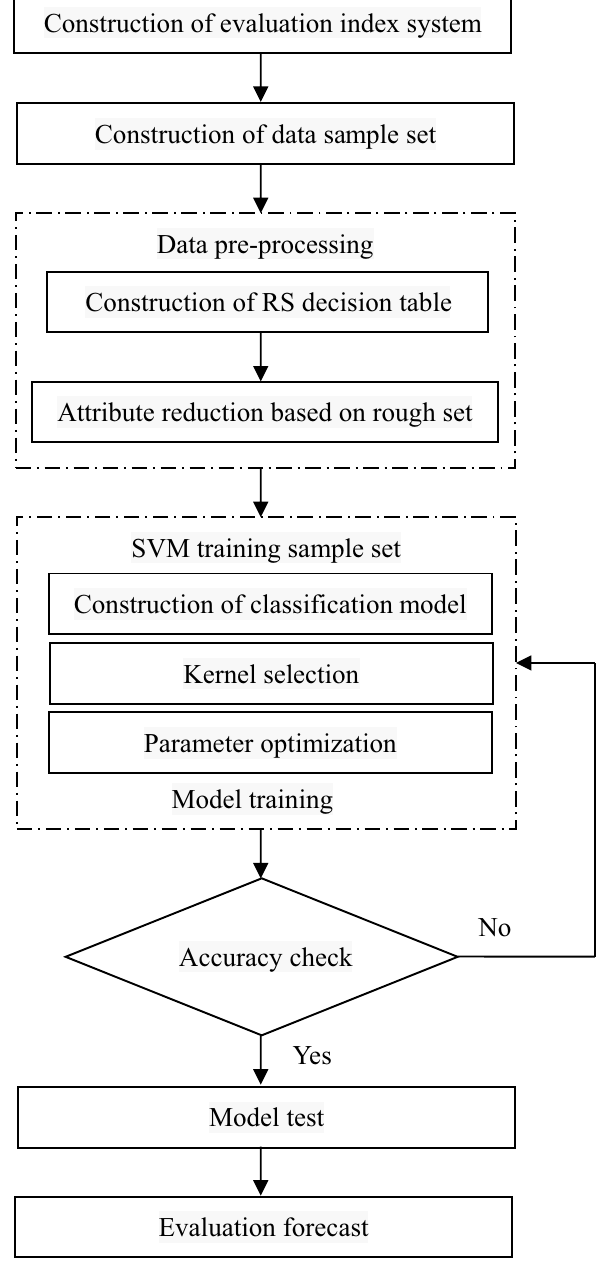
Figure 2. Flow diagram of highway landslide hazard evaluation based on